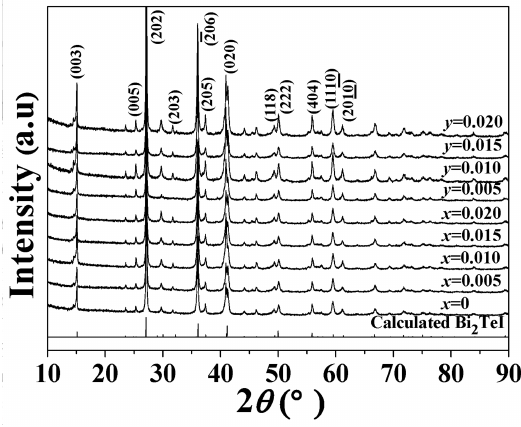
Figure 4. XRD patterns of Cu-doped Cu x Bi 2 TeI and Zn-doped Zn y Bi 2 TeI.